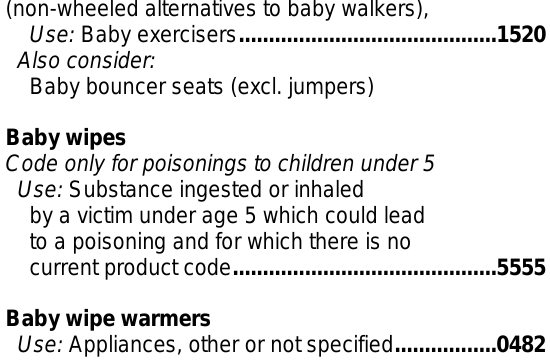
Baby monitoring devices (not medical) Choose among: Radios (self-contained units; Photographic equipment (excl.